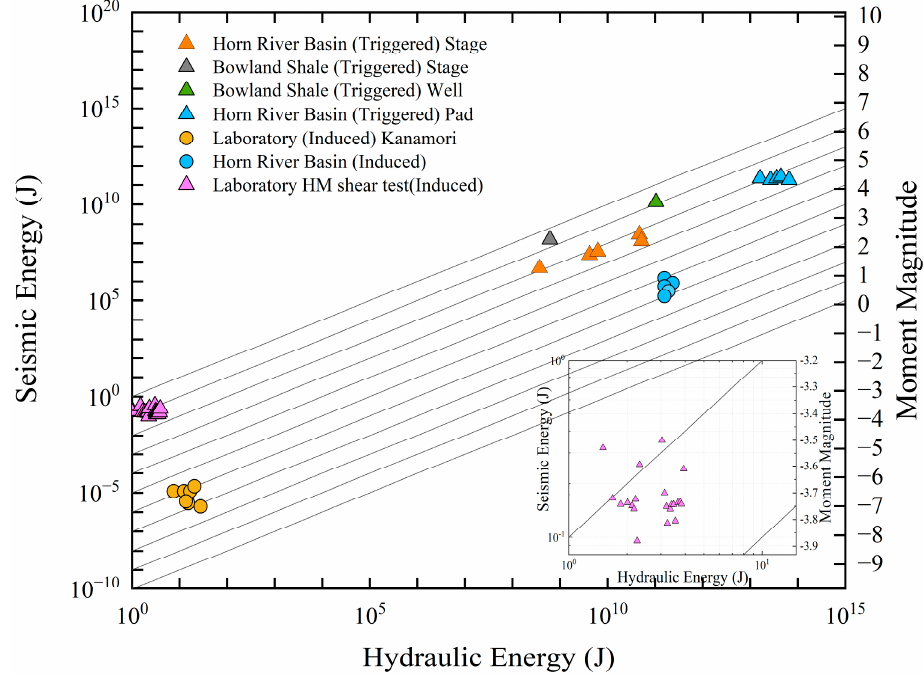
Figure 9. The injection energy is plotted against the seismic energy and moment